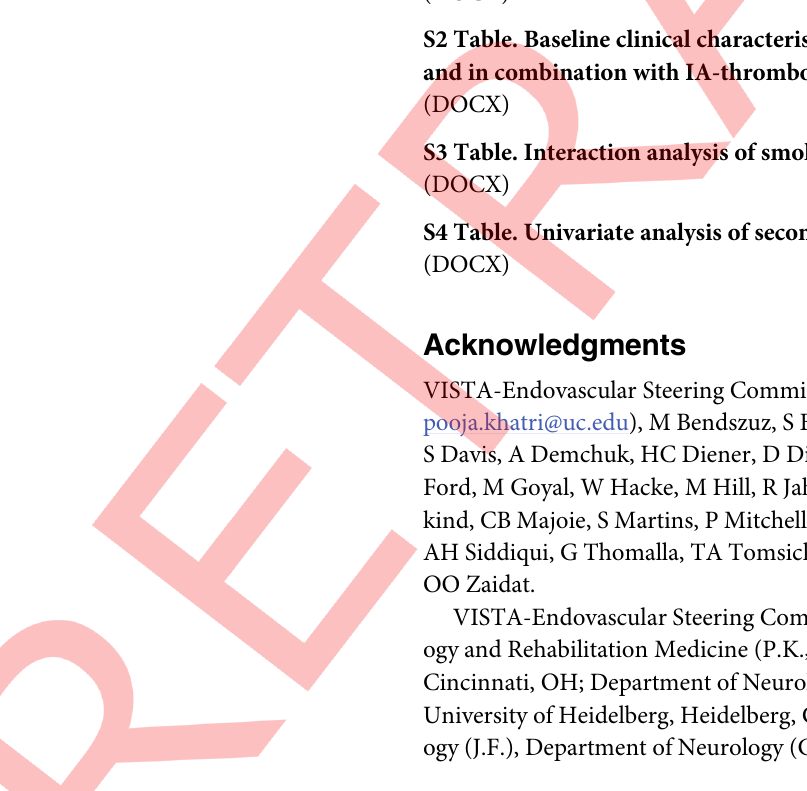
S1 Table. Regression analysis of primary endpoints according to mode of therapy. S2 Table. Baseline clinical characteristics of patients with mechanical thrombectomy alone and in combination with IA-thrombolysis according to smoking status. S3 Table. Interaction analysis of smoking and mode of treatment. S4 Table. Univariate analysis of secondary outcome parameters based on smoking